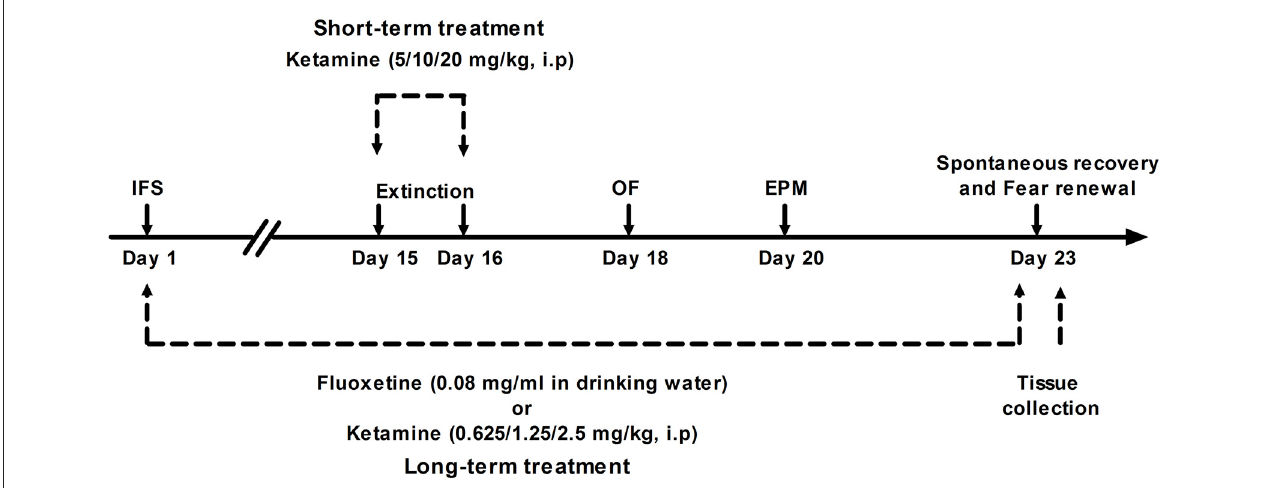
FIGURE 1 | Illustration of the experimental protocol. See text for details. IFS, inescapable electric foot shocks; OF, open field test; EPM, elevated plus maze test.